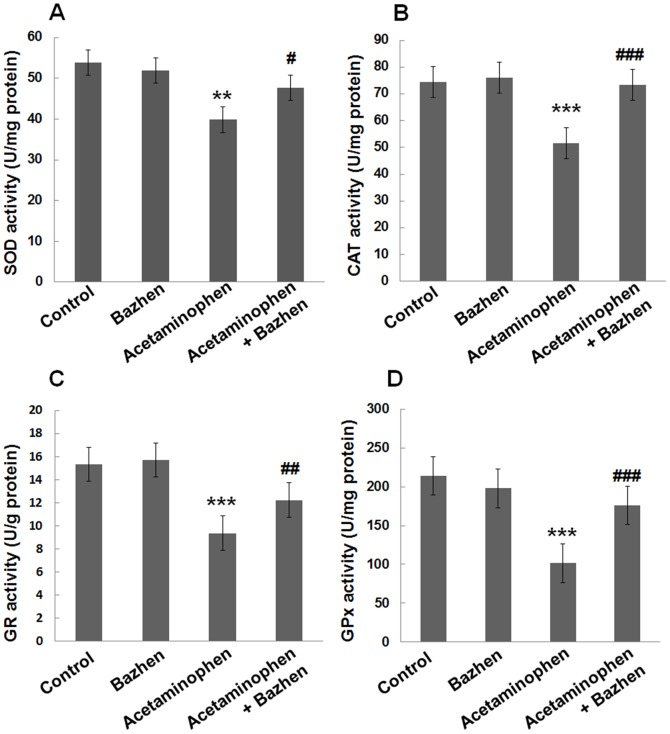
Effects of Bazhen decoction on the hepatic antioxidant enzymes activities in mice intoxicated with acetaminophen.(A) SOD, (B) CAT, (C) GR and (D) GPx. Values are expressed as means ± SD of 12 animals in each group. Significance difference were ***p<0.001 or **p<0.01 as compared with the control; ###
p<0.001, ##
p<0.01 or #
p<0.05 as compared with acetaminophen group.